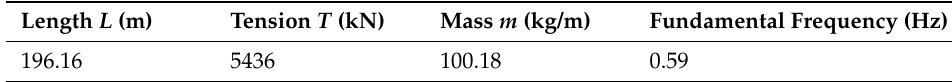
Table 1. Parameters of cable for the present study.